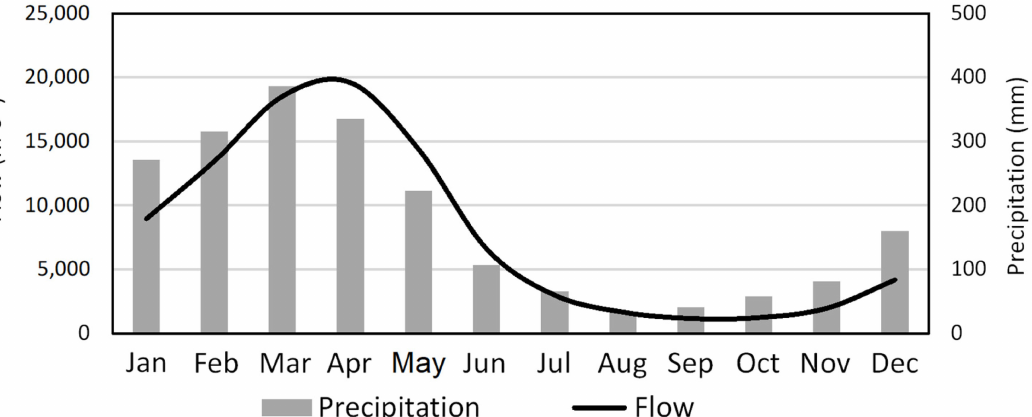
Figure 11. Monthly climatology of precipitation (bars) and flow rate (line) at Altamira based on the period